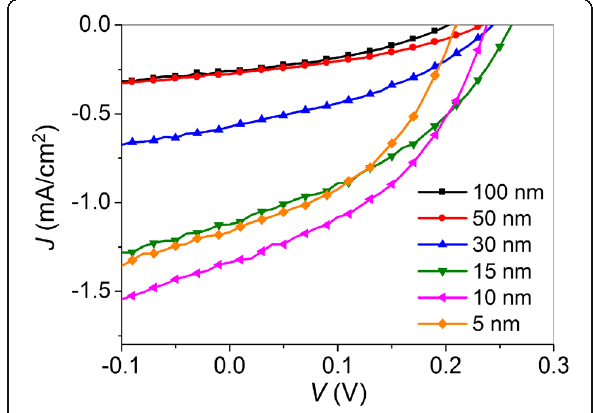
Fig. 4 J - V characteristics of the PSCs with the device structure of ITO/PEDOT:PSS/P3HT ( x nm)/C 60 (25 nm)/LiF (1 nm)/Al using varying thicknesses of